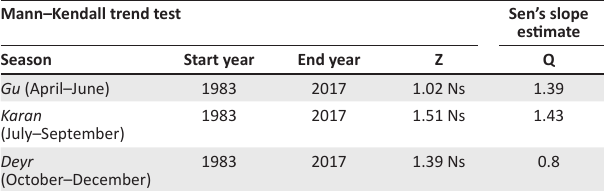
TABLE 7: Seasonal rainfall (mm) trends in Harshin 1983–2017.